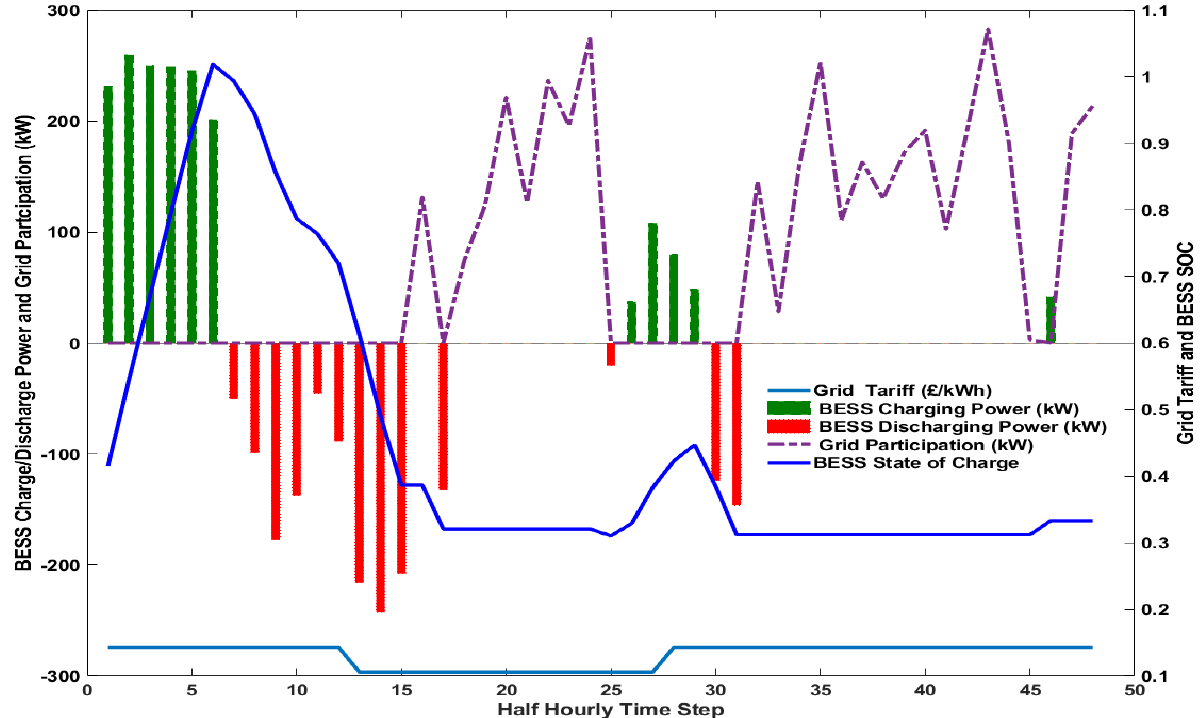
Figure 13. Grid participation, BESS SoC, grid tariff, and BESS charge/discharge command (Scenario 3).